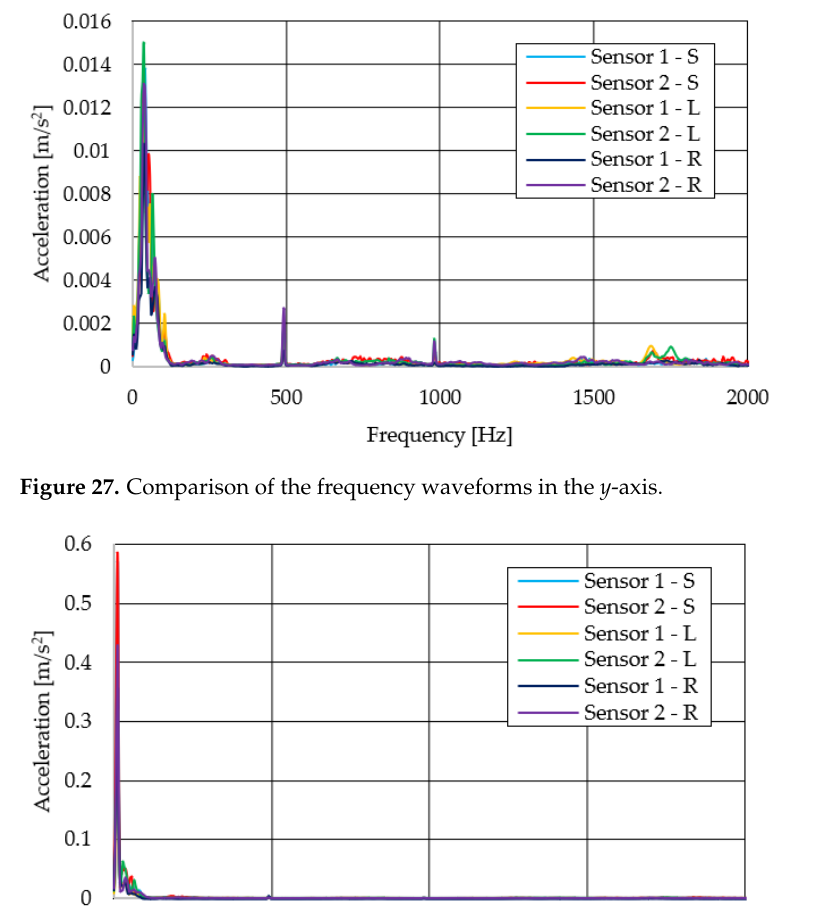
Figure 26. Comparison of the frequency waveforms in the x -axis.